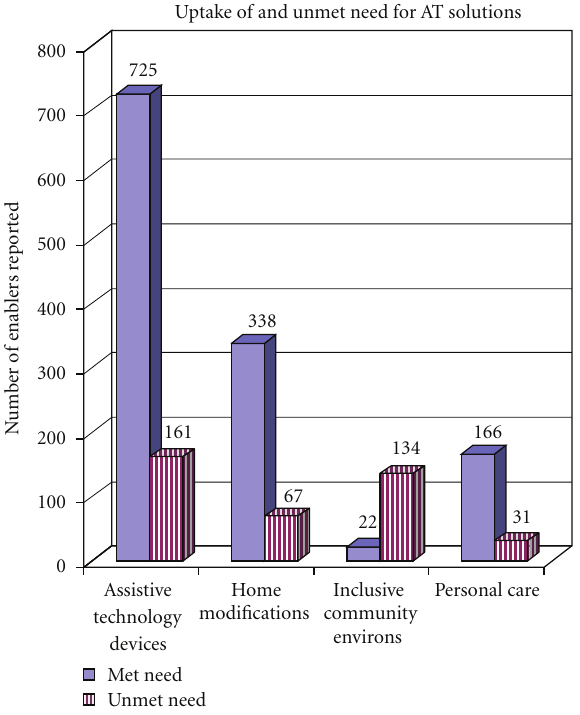
Figure 1: Uptake of and unmet need for AT